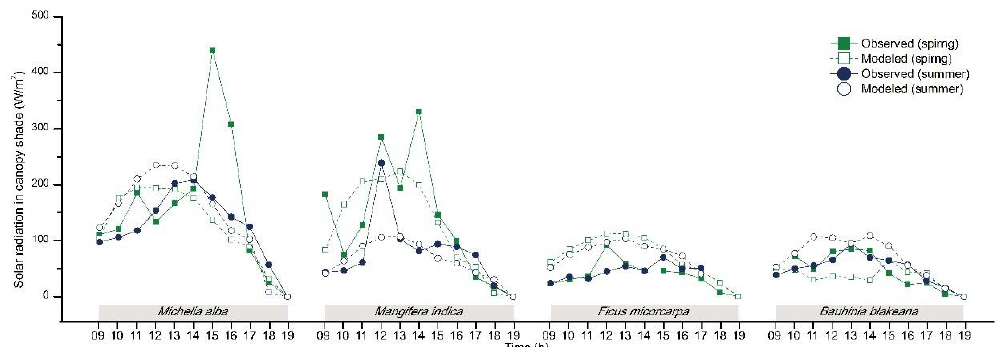
Figure 6. Comparison of modeled and observed solar radiation in tree canopy shading. Atmosphere 2018 , 9 , x FOR PEER REVIEW